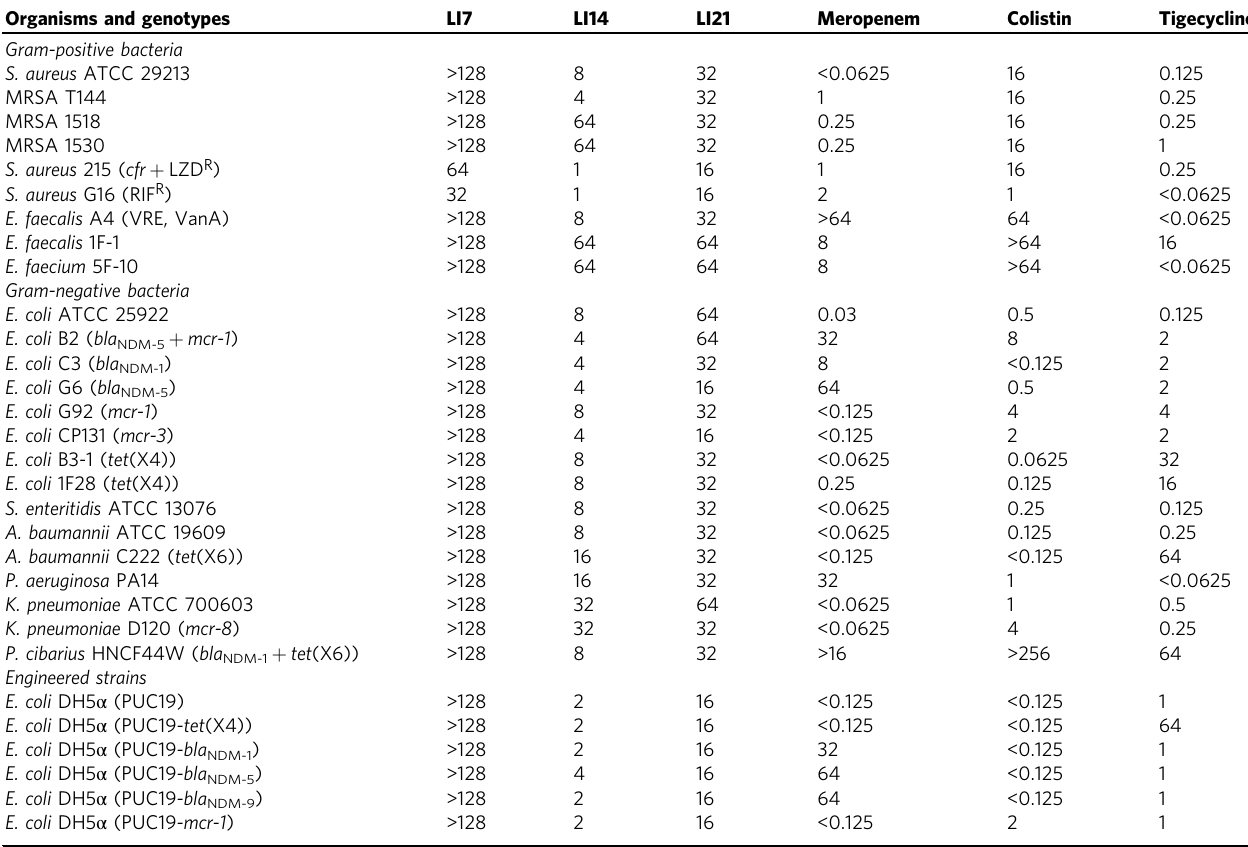
Table 1 Antimicrobial spectrum of engineered LI peptides (MIC, μ g/mL). Organisms and genotypes LI7 LI14 Gram-positive bacteria S. aureus ATCC